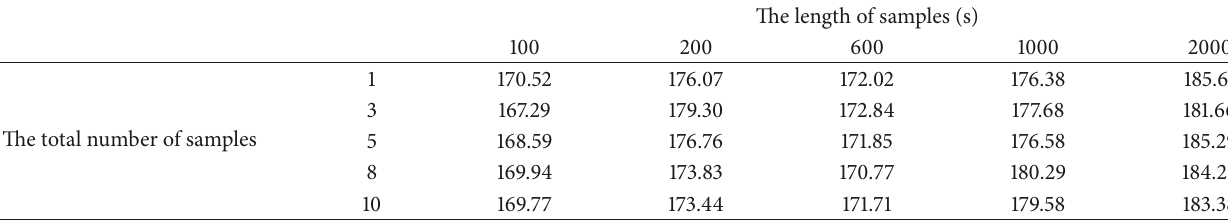
Table 3: The average of extremum Ux displacement on tower top node 35# (mm).